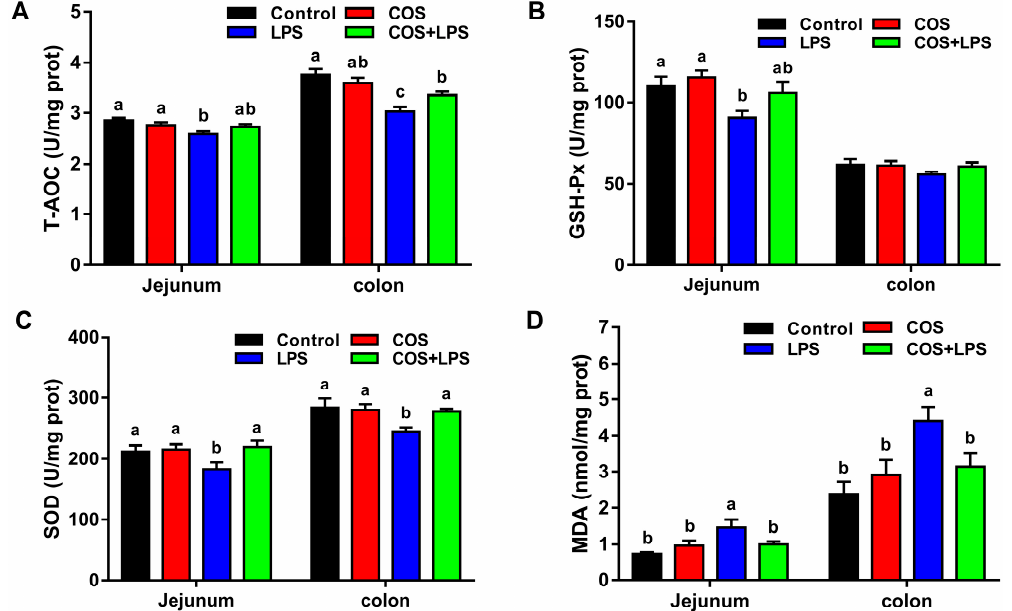
Figure 7. Effects of COS on antioxidant indicators in the jejunum and colon of mice. Activities of T-AOC ( A ), GSH-Px ( B ) and SOD ( C ) in the jejunum and colon. ( D ) Contents of MDA in the jejunum and colon. The data are presented as the mean ± SE ( n = 8). Values without a common letter are significantly different ( p < 0.05). COS, chitosan oligosaccharide; LPS, Lipopolysaccharide; prot, protein; T-AOC, total antioxidant capacity; GSH-Px, glutathione peroxidase; SOD, superoxide dismutase; and MDA,